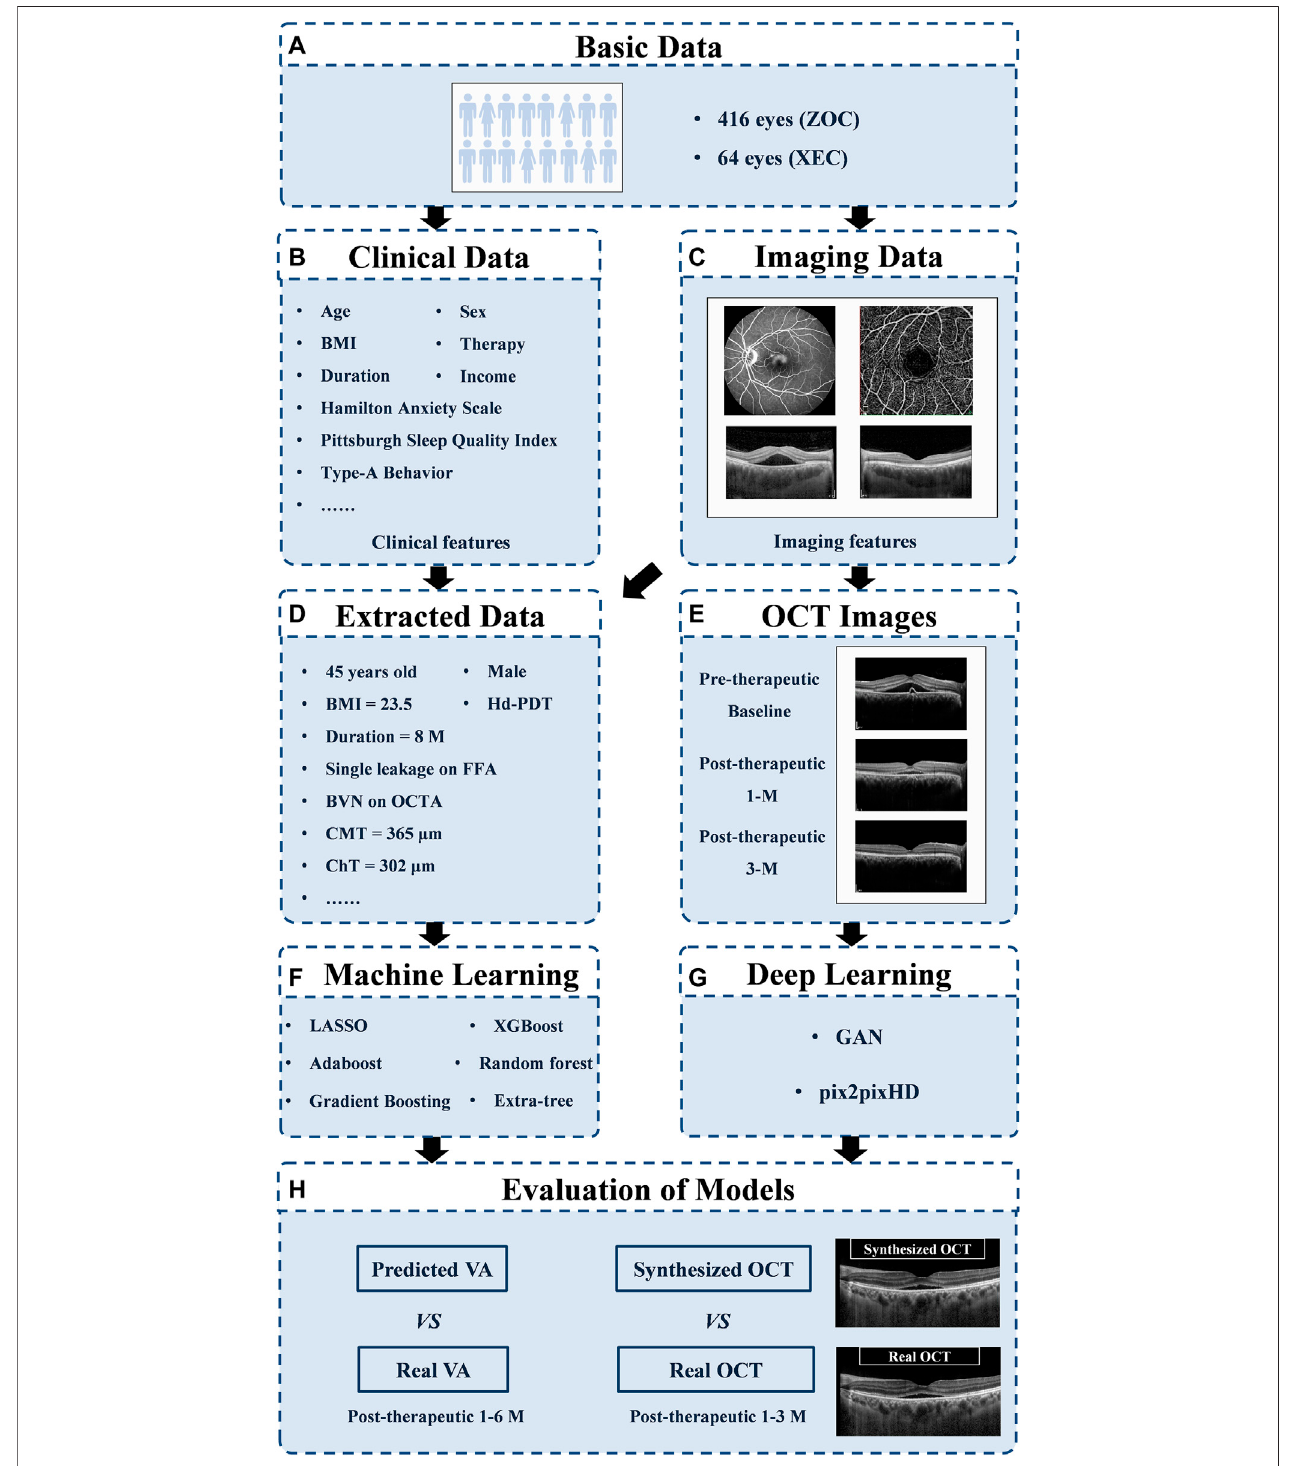
FIGURE 1 | Overall study work fl ow. Work fl ow diagram showing the training overview for the CSC prognosis prediction model. ZOC, Zhongshan Ophthalmic Center; XEC, Xiamen Eye Center; OCT, optical coherence tomography; GAN, generative adversarial network; VA, visual acuity.